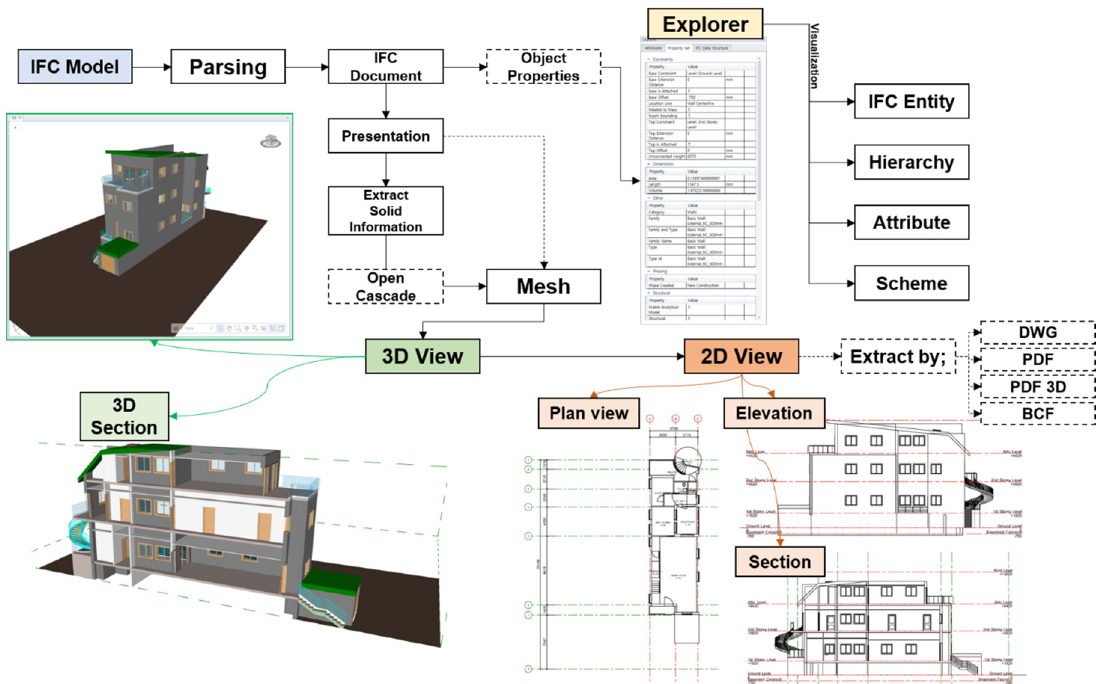
Figure 1. Process diagram depicting the process of the program for the openBIM-based automatic generation of 2D drawings.